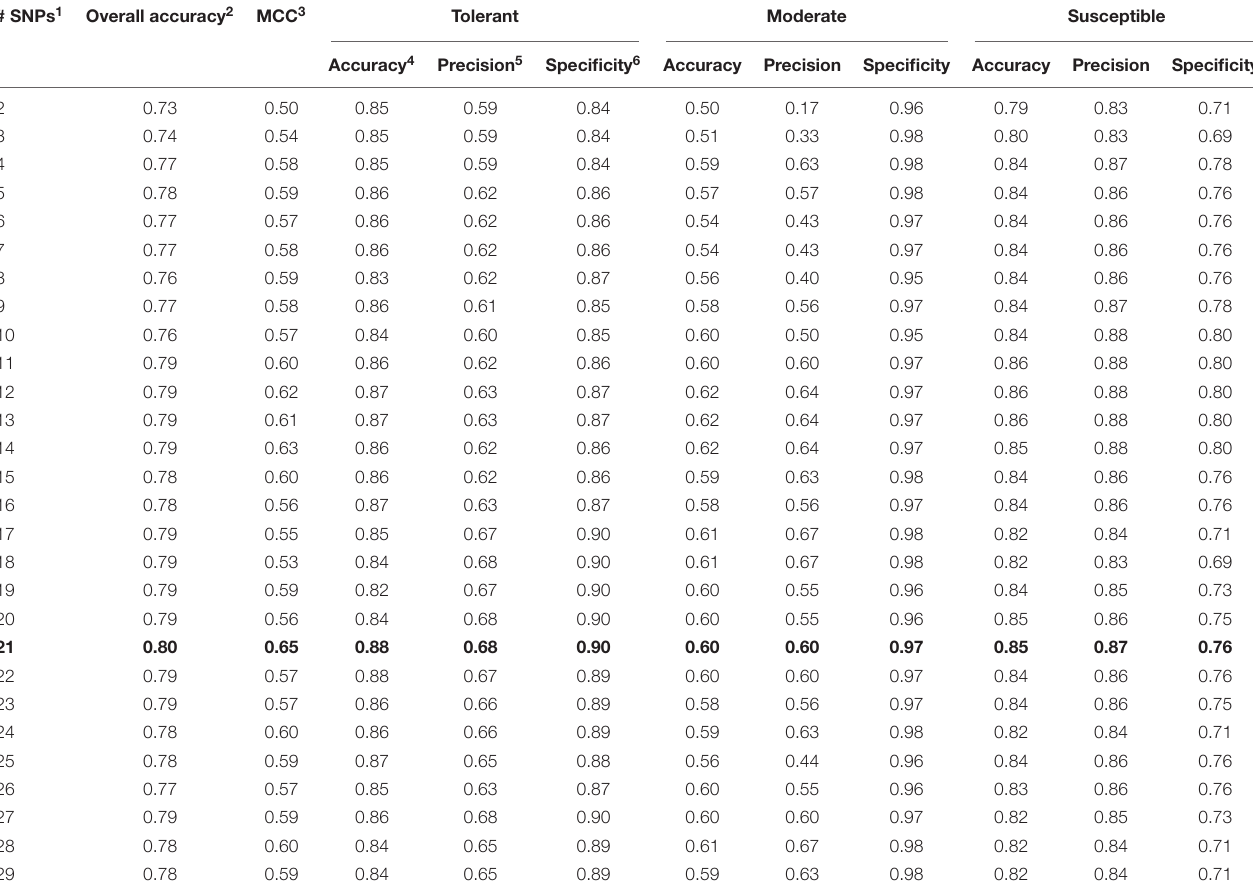
TABLE 2 | Summary of RF classification accuracy metrics based on the number of